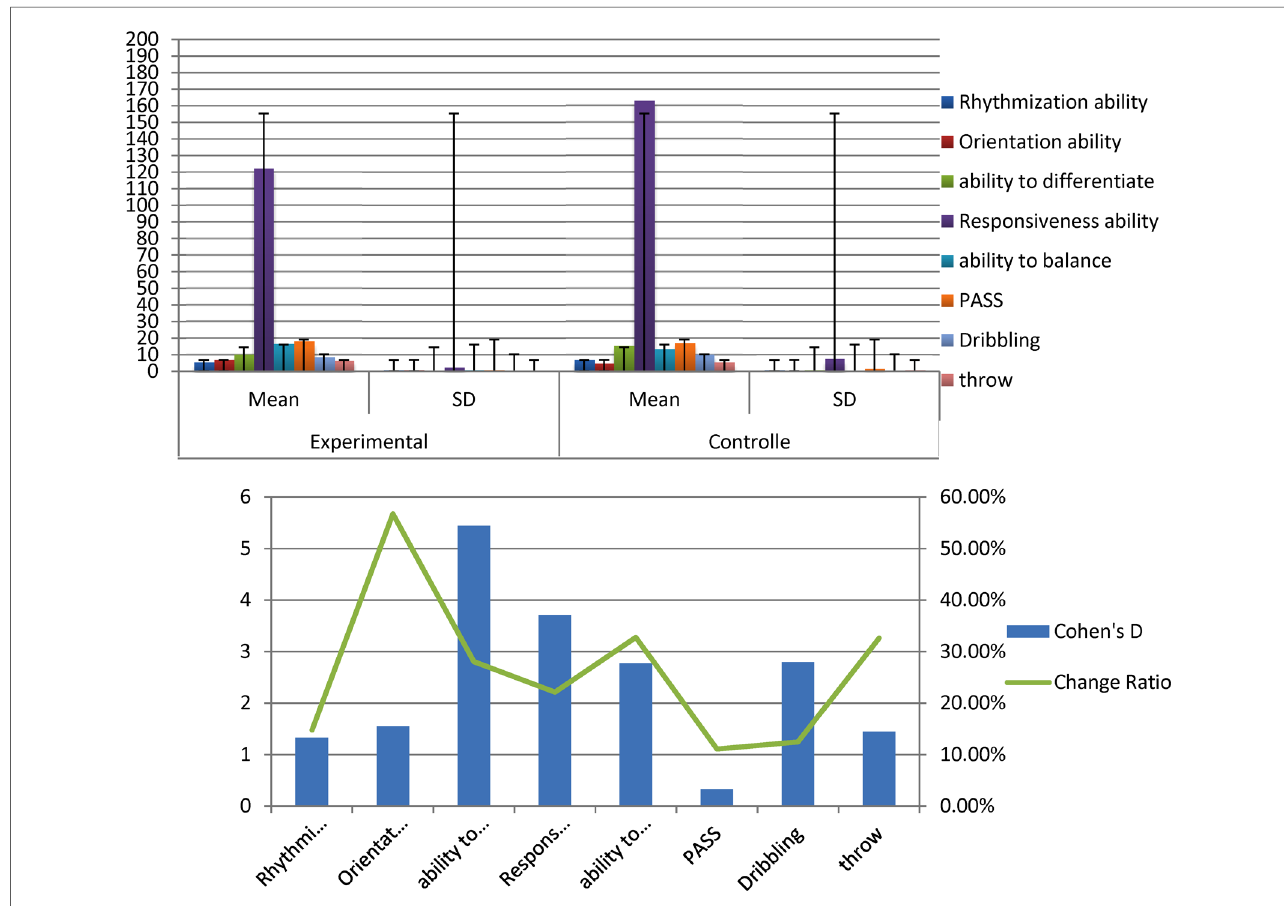
FIGURE 4 Indication of differences between the averages of post measurements of the experimental and controlled groups in the variables under